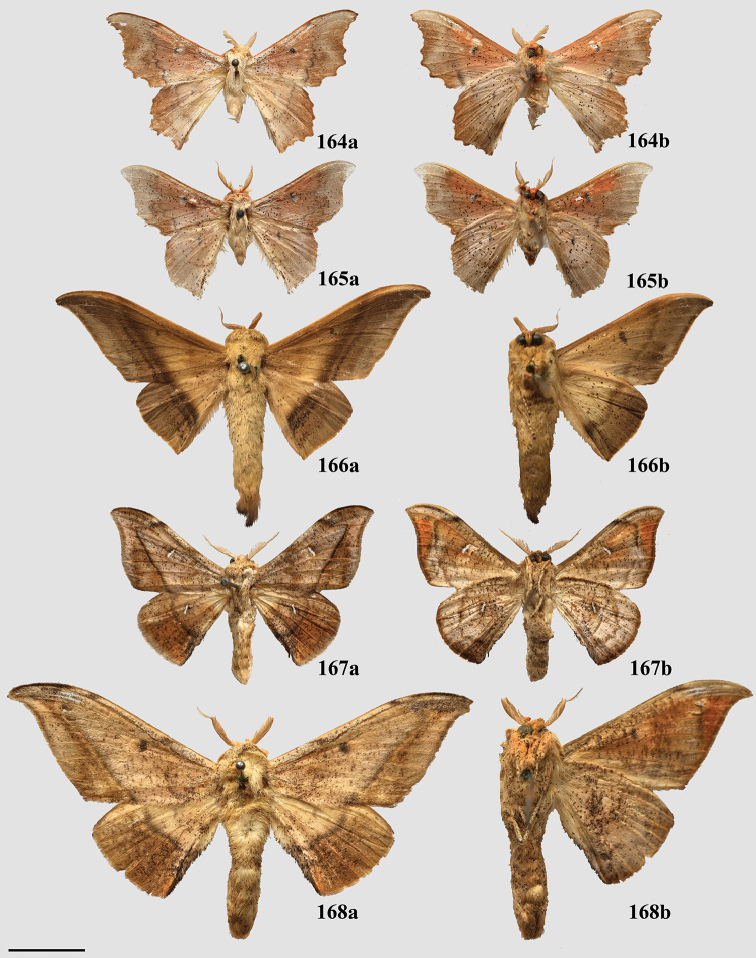
Lectotypes designated in the present work for Lacosominae and Cicinninaea dorsal b ventral. See annotations in Section 4 for complete label data for all lectotypes. All specimens are male. 164Lacosomadiederica Schaus 165Lacosomaraydela Schaus 166Cicinnuslacuna (= Psychocampalacuna) 167Cicinnuscorallina Dognin 168Cicinnuslatris Schaus. Scale bar: 1 cm.